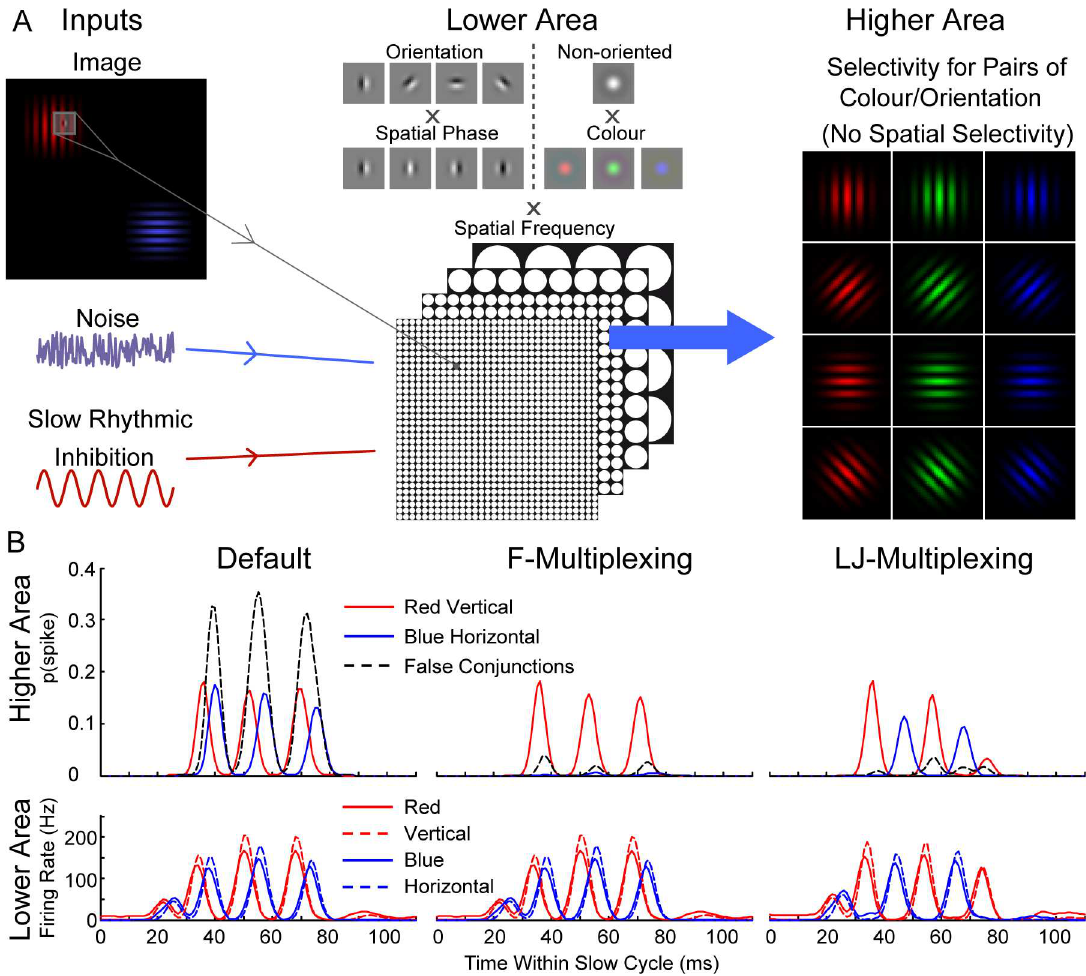
Fig 7. The feature-pair conjunction model. A. The lower area of the model is similar to the first model (Fig 2), with retinotopically arrangedlayers of excitatory and inhibitorycells, but with the addition of layers of excitatory cells selective for stimulus colour (red, green and blue), again duplicatedacross spatial scales, but without orientationselectivity. The higher area is more significantly modified: in this case, there is no spatial selectivity, with all cells receivinginputs from the full spatial extent of the lower area. Instead, due to restricted connectivity, these cells are selective for particular colour-orientation conjunctions, as indicateddiagrammatically. B. Summary of network activity in response to a red-vertical stimulus patch, and a slightly lower contrast blue-horizontal patch, across the same three network states as describedearlier (default, F- and LJ- multiplexing), showingthe activity across one slow oscillatory cycle for each state (average of 1 s simulated activity, 100 simulation repeats). Plots of mean firing rate vs phase of slow oscillationare shown for activity in the lower area. For the higher area, the probability of firing at a given time point is shown, for each of the correctly activated conjunction cells (red- vertical and blue-horizontal) as well as for either of the false conjunctions (red-horizontal or